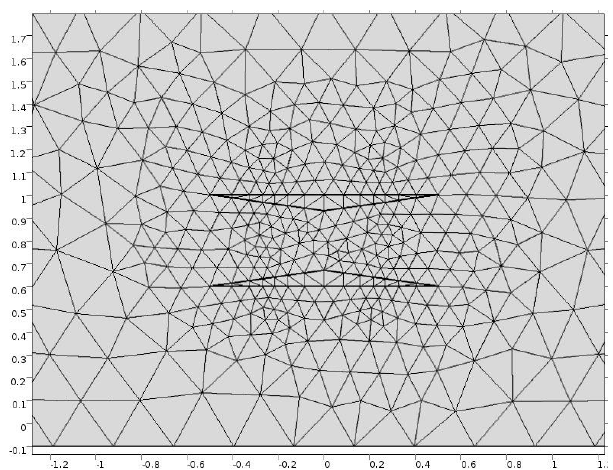
Figure 1. The three-dimensional model of the closed type WPP construction and roof of the building